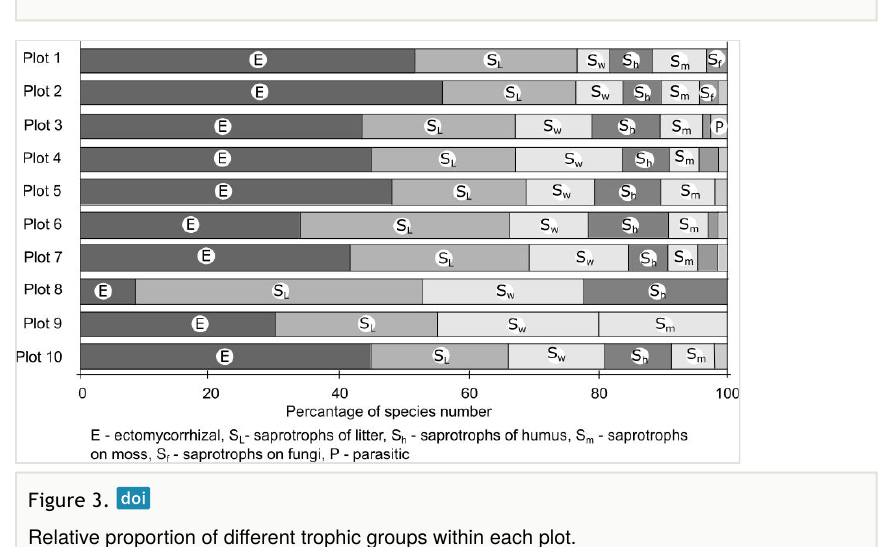
Relative proportion of di ff erent trophic groups within each